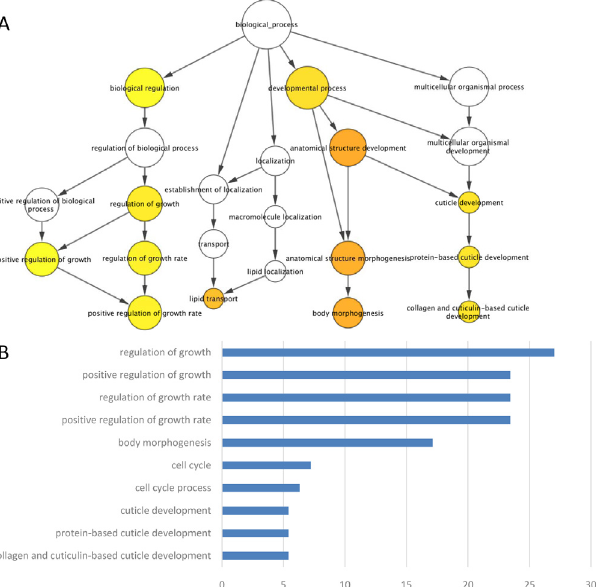
Fig 4. The Gene Ontology-based functional analysis of differentially expressed genes in larval stage 4. (A) The Gene Ontology-based functional analysis of differentially expressed genes in the form of biological network; (B) Top 10 enriched Gene Ontology terms of RF exposure associated genes. The significance levels ( P- value) were analyzed between RF exposure and sham control groups. Only GO terms that were enriched > 1.5 fold over the average and with a P -value < 0.05 were considered to be significant enriched